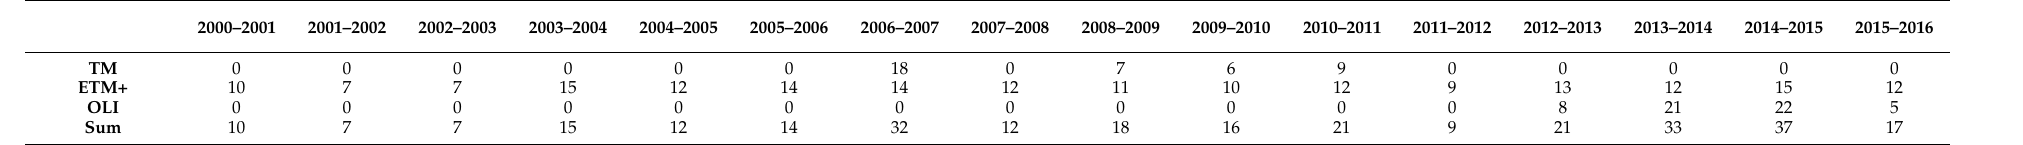
Table 1. Frequency of all available Landsat images for the study area by